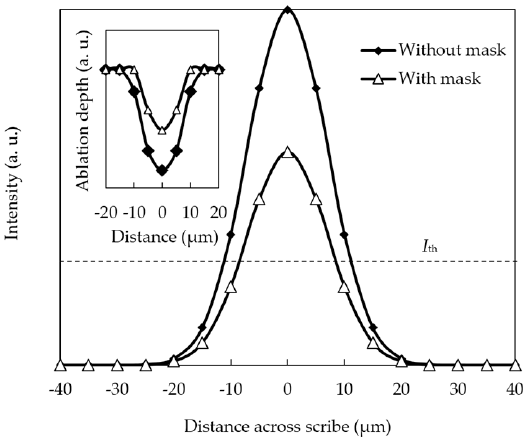
Figure 3. Theoretical calculation results of laser intensity and ablation depth distribution across the scribes for submodules with and without mask.